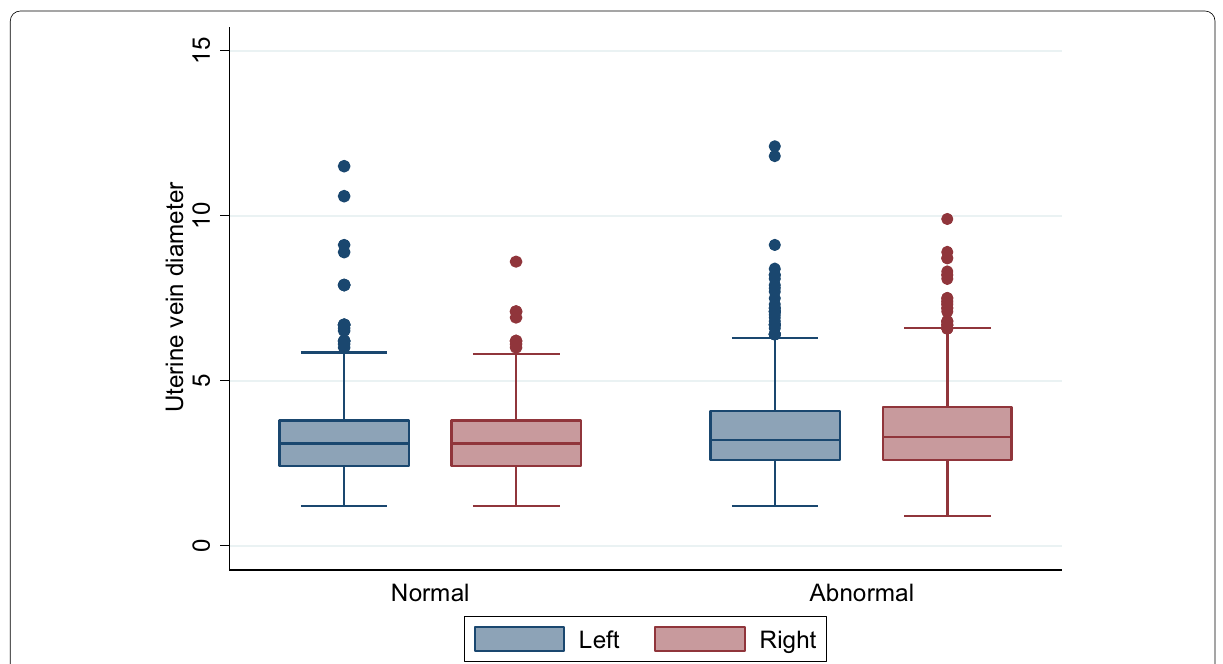
Fig. 3 Differences in uterine vein diameter between all women with normal pelvic organs and those with pelvic